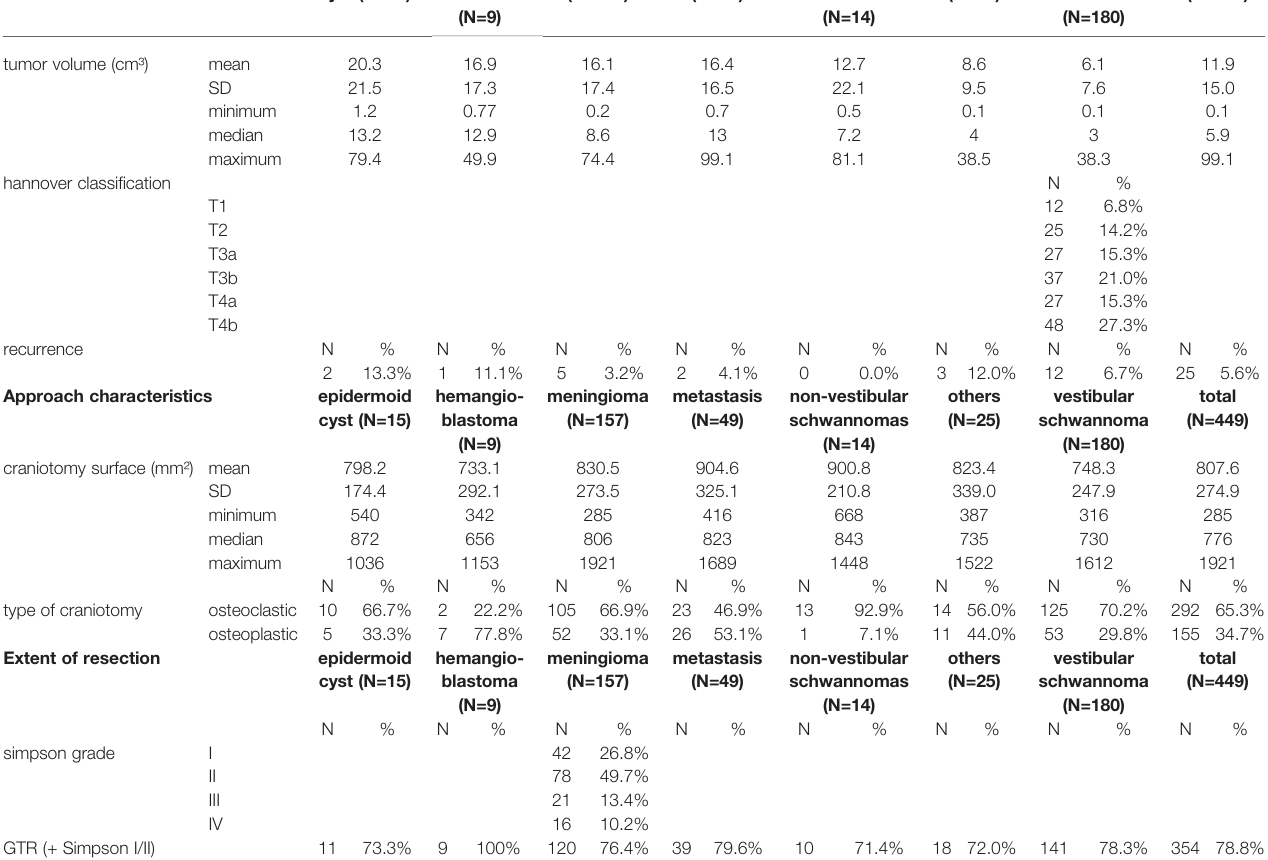
TABLE 2 | Tumor- and approach-related characteristics and the extent of resection. Tumor